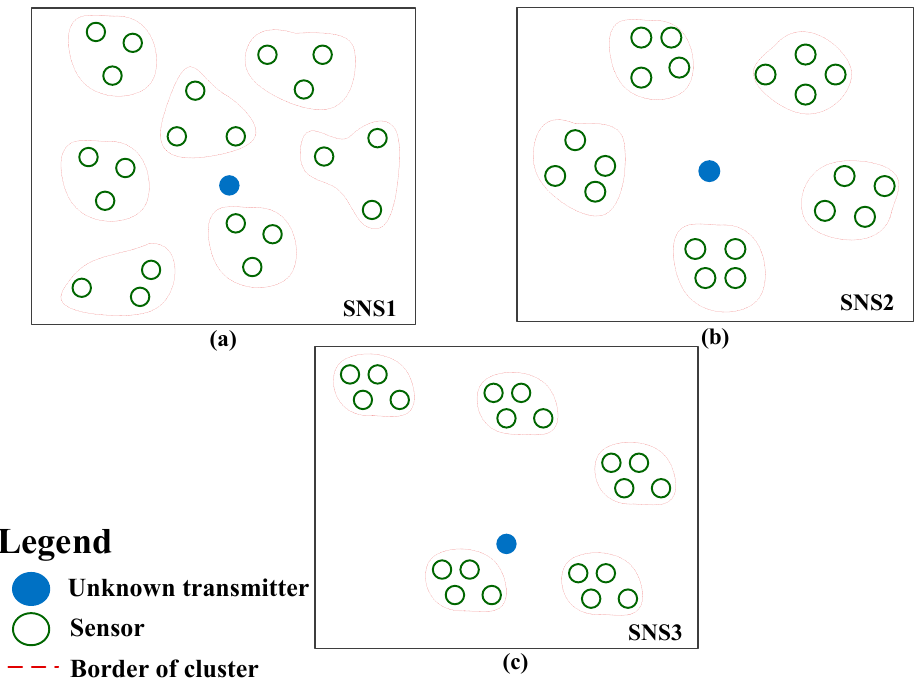
Figure 5. Di ff erent sensor network scenarios depending on the cluster spacing around a Figure 5. Different sensor network scenarios depending on the cluster spacing around a transmitter, ( a ) SNS1—Clusters are spaced in different directions and on different distances from the transmitter,